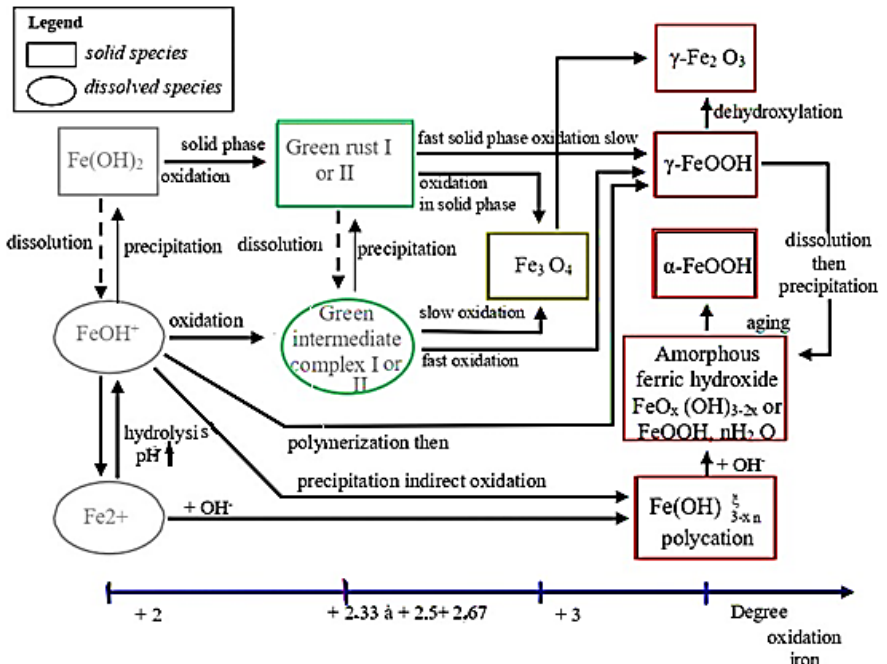
Figure 2. Reaction scheme governing the appearance and evolution of species in aqueous solution during the iron oxidation process. For this study, Misawa et al. and Cornell and Schwertmann found that the presence of ferrous ions in solution is dependent on the oxygen level and pH. When the oxygen level is high and the pH is below 6, ferrous ions remain in solution. However, if the pH is above 6, ferrous hydroxide (Fe (OH) 2 ) precipitates and quickly transforms into Fe (OH) 3 due to oxidation and hydrolysis. The oxidation rate of green rusts (Fe (OH) 2 ) determines the formation of lepidocrocite (γ -FeOOH) or magnetite (Fe 3 O 4 ). Magnetite is a thermodynamically stable phase, but in the presence of iron in an oxidation state between +II and +III, it can evolve into a similar structured phase, maghemite (γ -Fe 2 O 3 ), at a higher iron oxidation degree. γ - FeOOH can transform into various forms including γ -Fe 2 O 3 , amorphous ferric ox- yhydroxide (FeOx (OH) 3 − 2x ), or ferrihydrite (FeOOH, n H 2 O) through different processes such as dehydroxylation or dissolution–precipitation. These phases have poor crystalliza- tion and eventually evolve over time to become the more thermodynamically stable phase, goethite α -FeOOH. In the long term, Fe (OH) 3 can transform into goethite α -FeOOH through loss of wa- ter. If the oxygen level is low, ferrous ions can react directly with OH anions to form un- stable compounds such as Fe (OH) 2 or Fe 2 (OH) 3 Cl in the presence of chlorine [15]. 3.2. Atmospheric Corrosion of Iron Metals are not only unstable when in contact with or immersed in corrosive solutions, there is another type of corrosion in contact with air, called atmospheric corrosion. This type of corrosion is due to the degradation of metal objects when exposed to air and its elements such as oxygen, humidity, and pollutants. The formation and disappearance of